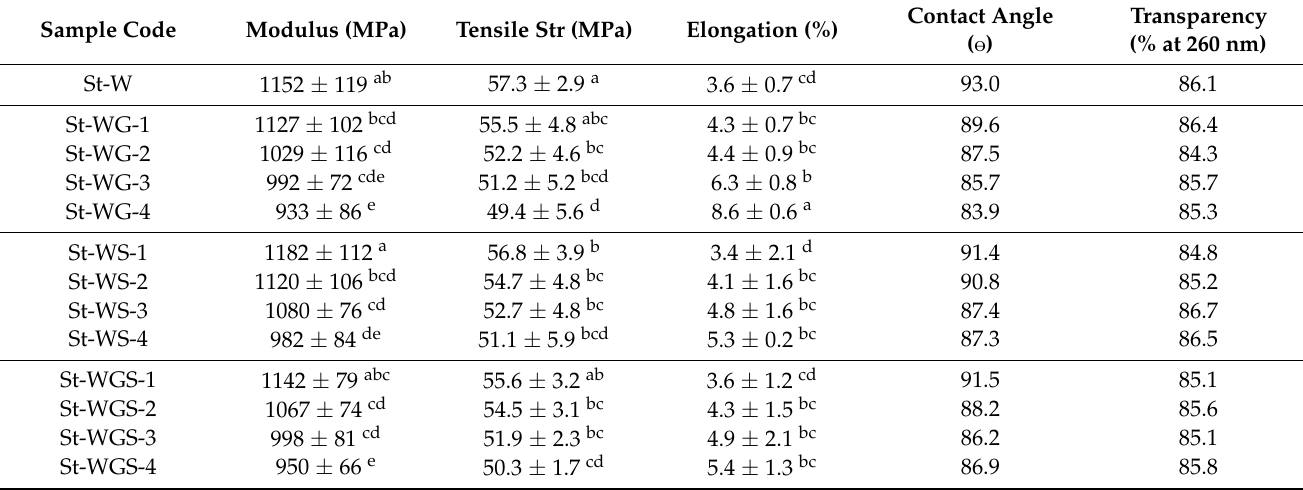
Table 2. Effect of different plasticizers on mechanical properties, contact angle, and